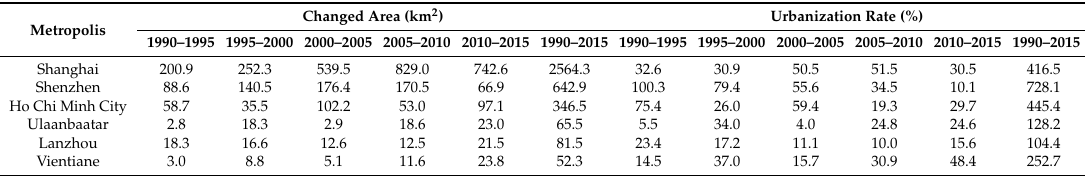
Table 4. Comparison of impervious surface change area and urbanization rates among six metropoles. Changed Area (km 2 ) Urbanization Rate (%) Metropolis